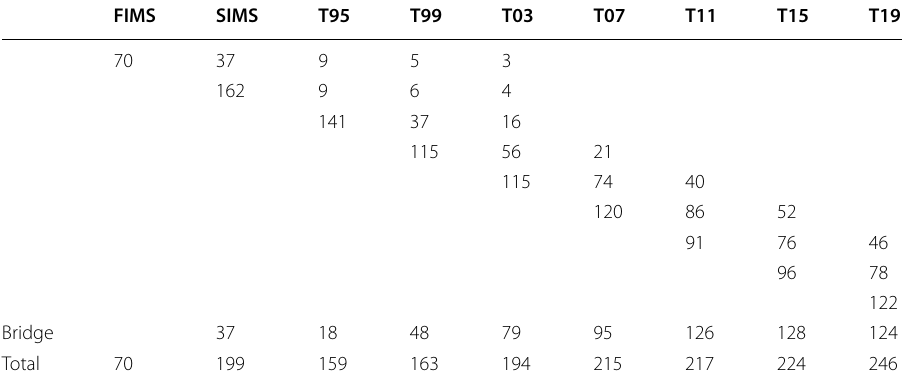
This table shows item overlaps across the assessments over time. The TIMSS assessments are denoted by T and the last two digits of the year of the assessment cycle. Numbers in the same row represent common items between surveys. The number of items common with the preceding administration is shown in the bridge row. The total number of items in the item pool per administration is shown in the total row. For example, 37 items, which were administered in FIMS, were repeated in SIMS, out of which nine were repeated in TIMSS 1995, then five of these items were also administered in TIMSS 1999, and finally, three of them were included in TIMSS 2003